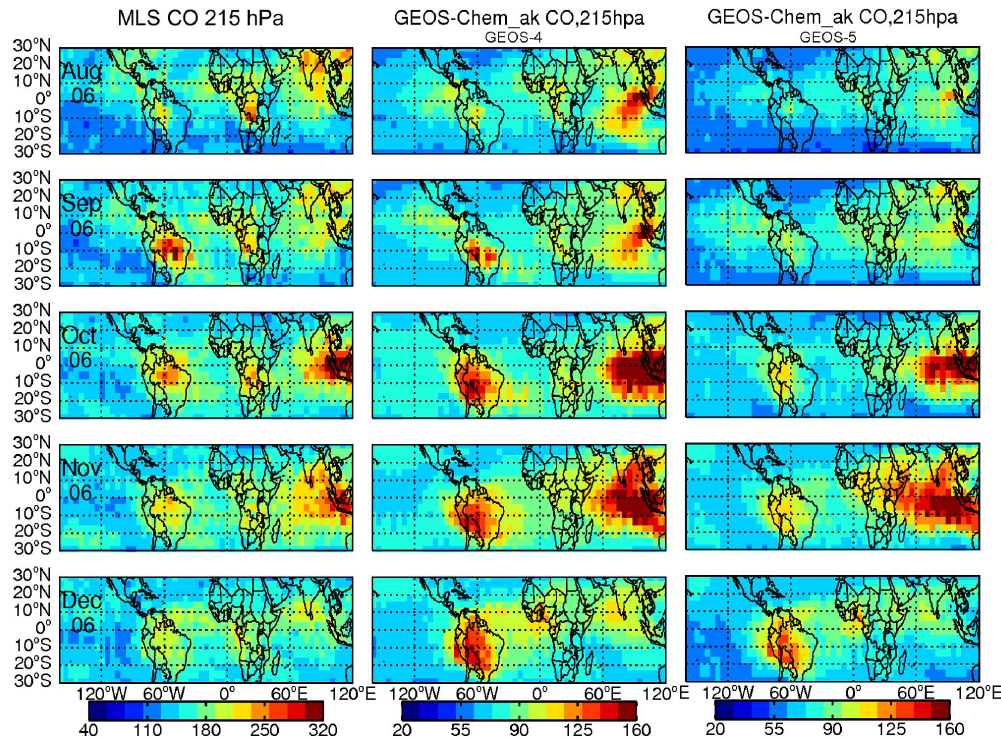
Fig. 6. Upper tropospheric CO at level 215hPa from August to December 2006 from MLS (left), the simulations driven by GEOS-4 (middle) and GEOS-5 (right) with the MLS AKs applied. See Fig. 5 for further details.